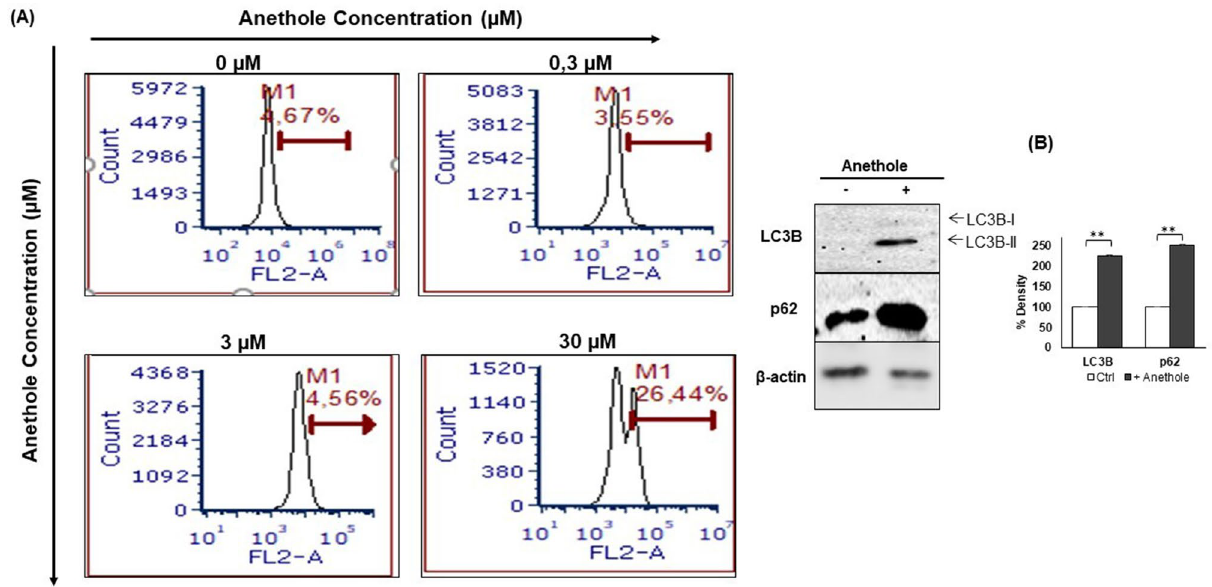
Figure 4. Anethole induces autophagy of oral cancer cells. ( A ) represents the flow cytometry analysis (n = 3). The results were reported with the means (% autophagy) ± SD and are considered significant when * p < 0.05. ( B ) Protein level of LC3B by western blotting (n =